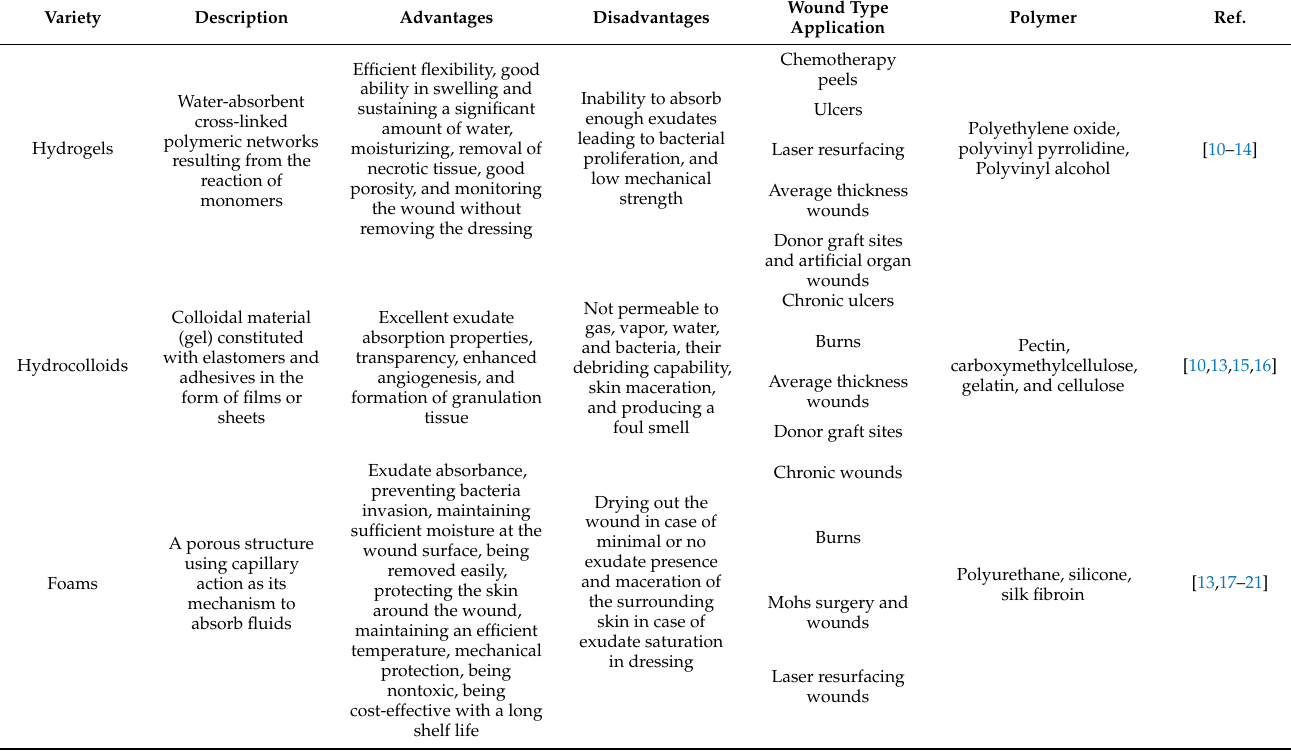
Table 1. Different types of wound dressings, their wound target, and polymer